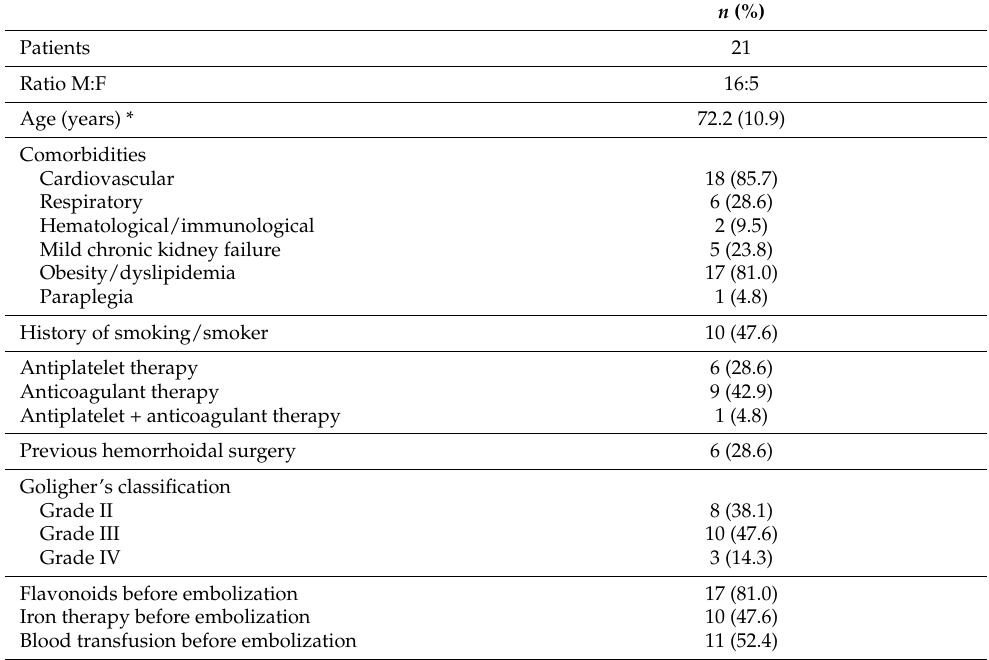
Table 1. Baseline patients’